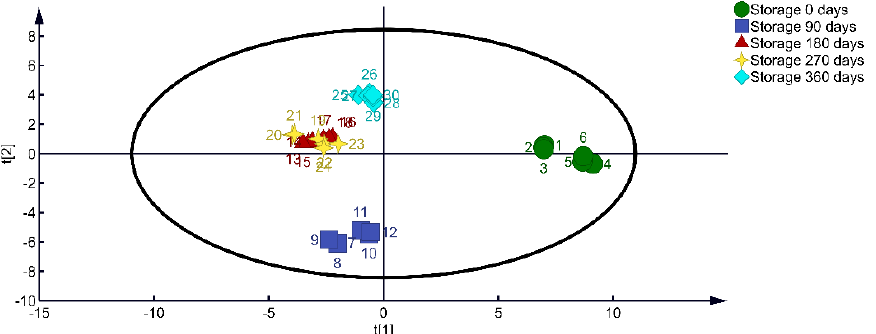
Figure 6. OPLS − DA 2D scores of alfalfa at different storage durations. Figure 6. OPLS−DA 2D scores of alfalfa at different storage durations. Figure 6. OPLS−DA 2D scores of alfalfa at different storage durations.